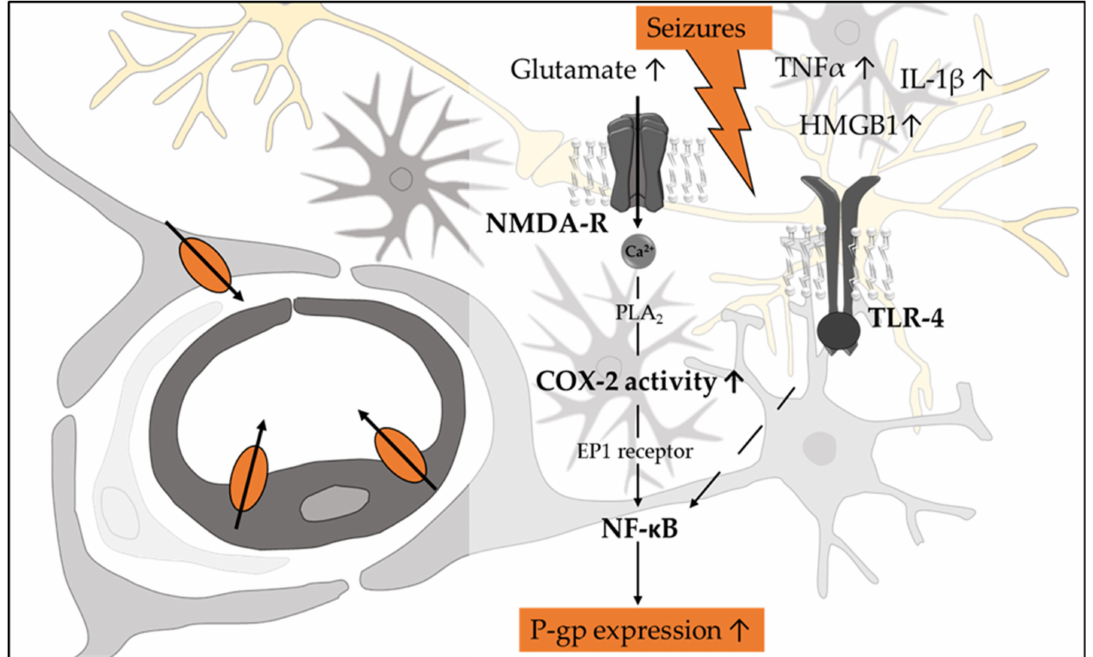
Figure 3. Schematic on the mechanisms assumed to be involved in seizure/epilepsy-induced upregu- lation of P-gp expression in affected brain tissue. Seizures increase the amount of glutamate-activating N-methyl-D-aspartate receptor (NMD-R) and thereby the calcium content. Activated phospholipase A 2 . (PLA2) cleaves phospholipids generating the cyclooxygenase 2 (COX-2) substrate arachidonic acid, which is catalyzed forming prostaglandin E2 (PGE2). PGE2 is assumed to activate the PGE2 receptor EP1, which modulates P-gp expression involving NF- κ B. This transcription factor is also modulated by involving the Toll-like receptor 4 (TLR-4) and the inflammatory mediators: interleukin (IL)-1 β , tumor necrosis factor (TNF)- α , and high-mobility group box-1